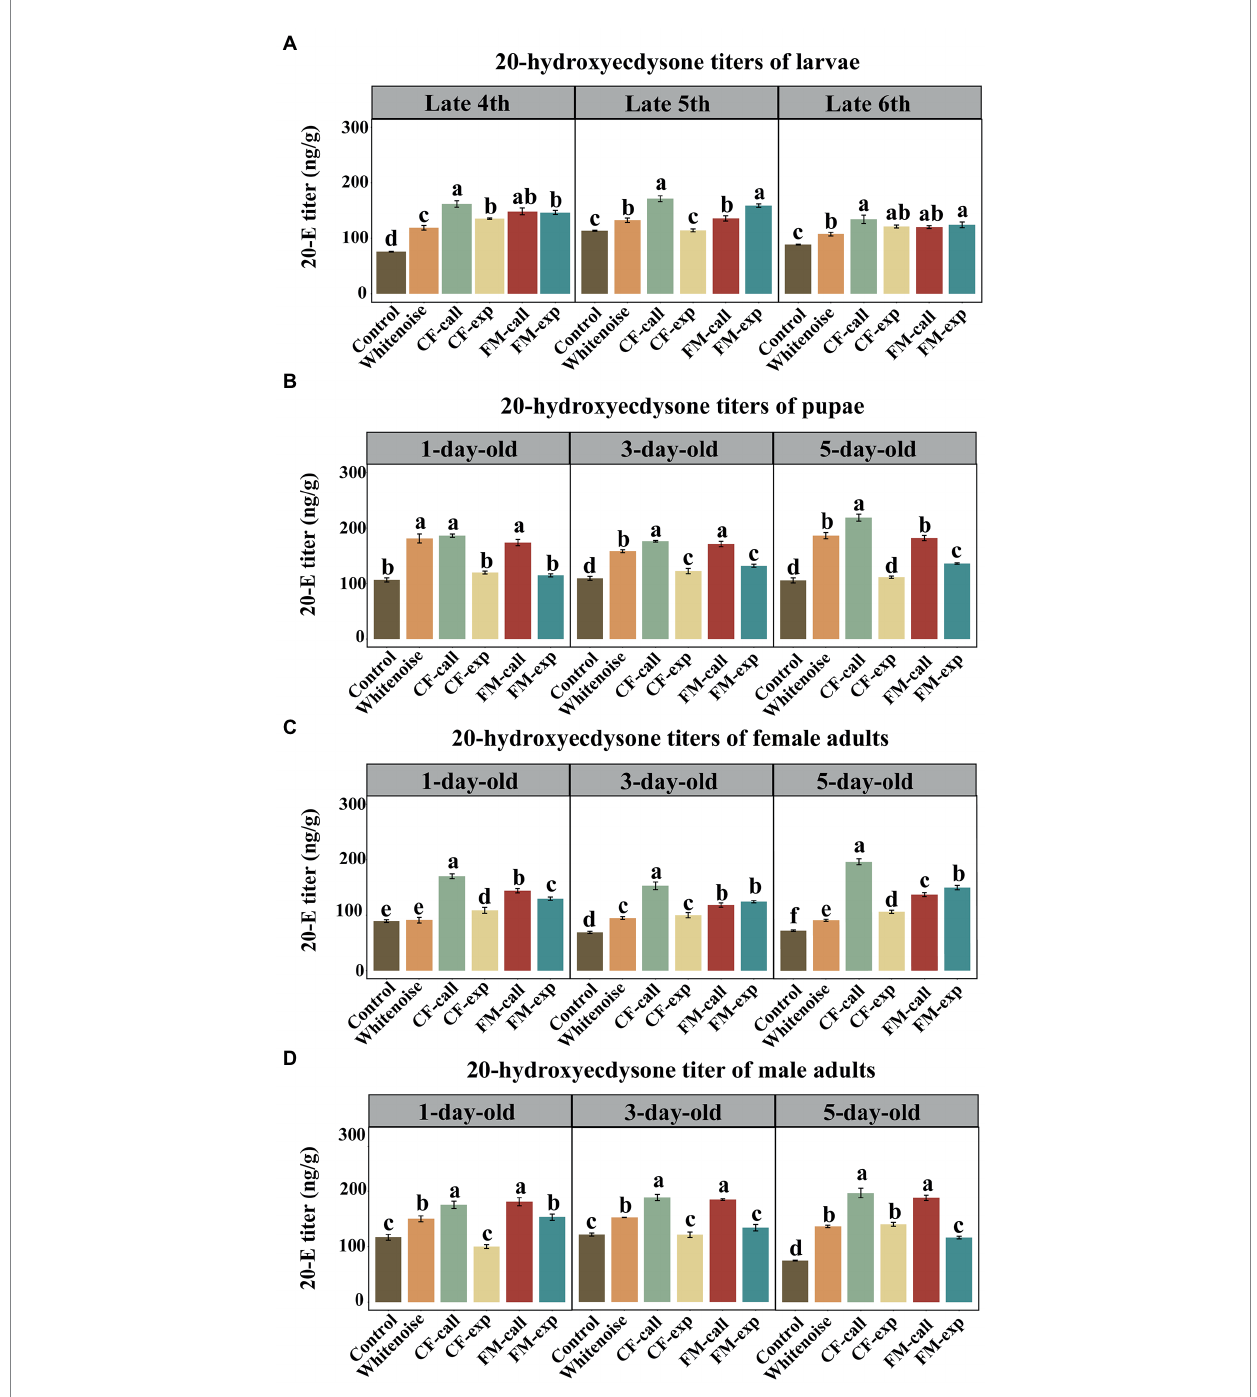
FIGURE 4 The 20-E titers in the different life stages of S. litura under different types of predation risk. The 20-E titers of (A) larvae, (B) pupae, (C) female adults, and (D) male adults. The data are expressed as the mean ± SD. Different letters on the bars indicate significant differences between treatments (Tukey’s test, p <